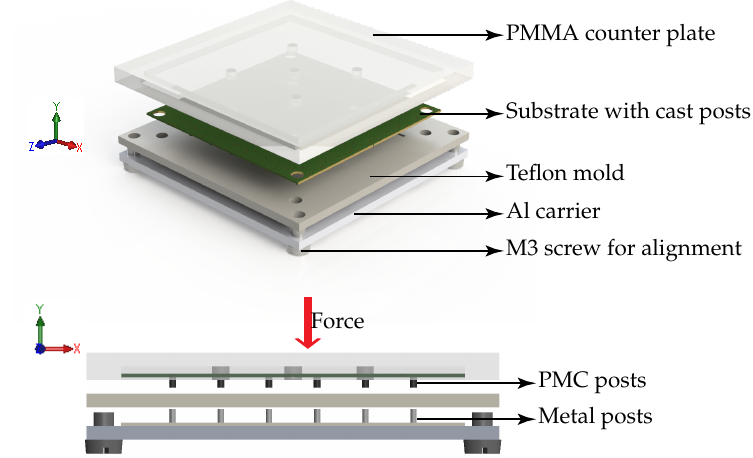
Figure 5. Schematic of the demolding method utilizing the PMMA press to distribute the force along the